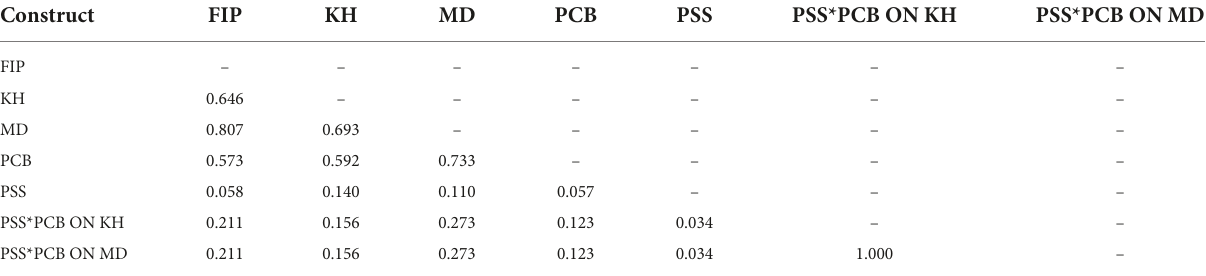
TABLE 8 Discriminant validity (HTMT) (moderation).